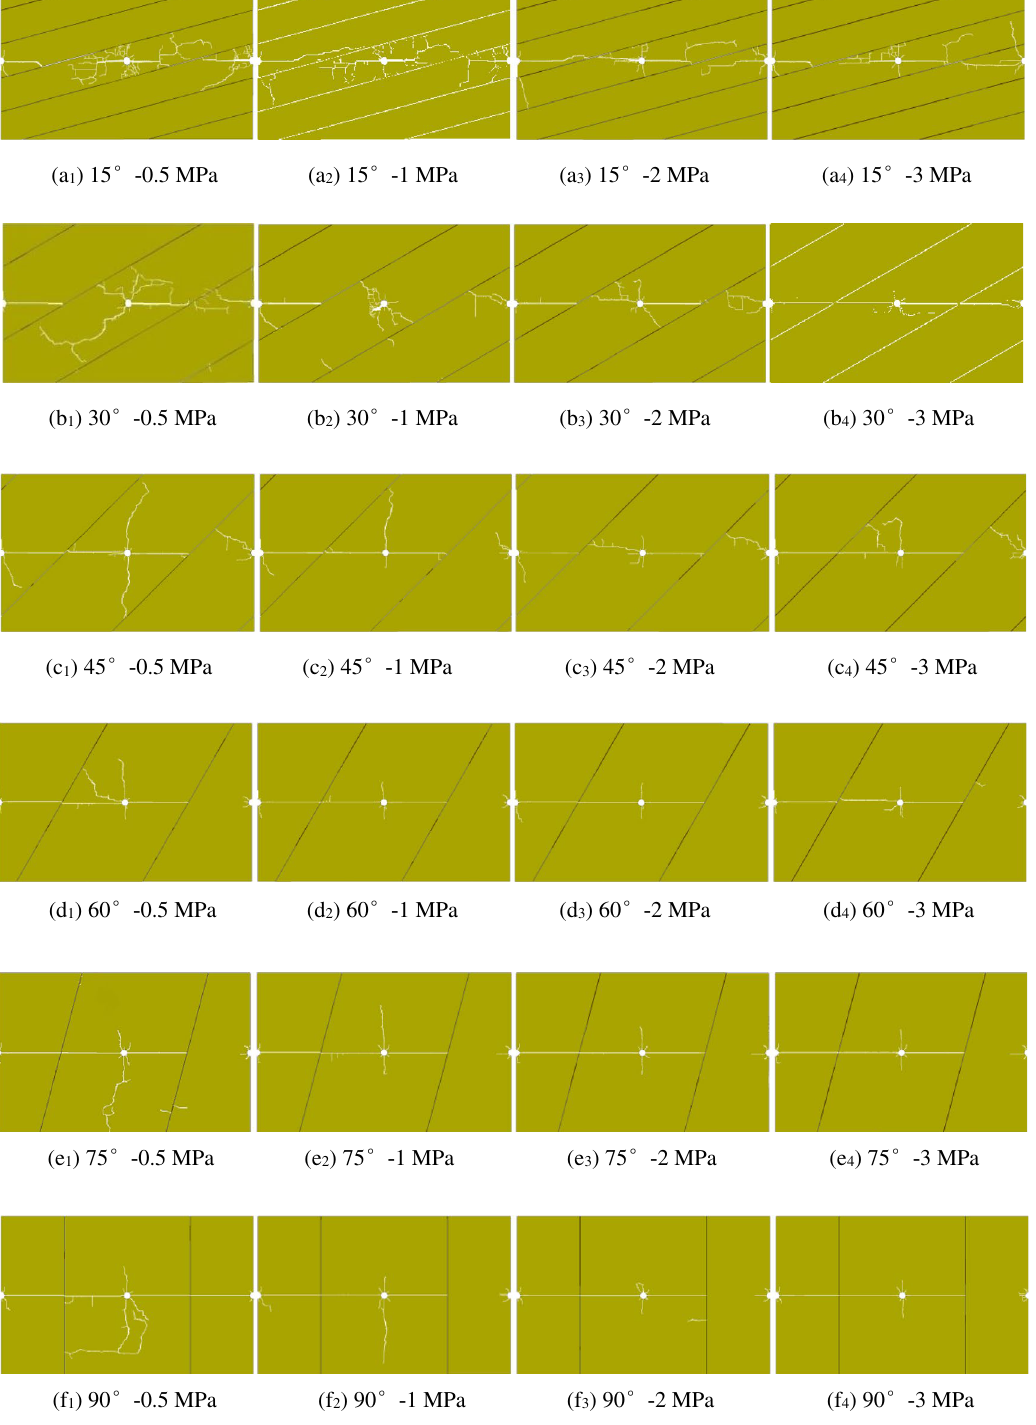
Figure 12. Crack penetrating results at different joint directions and tensile strengths.